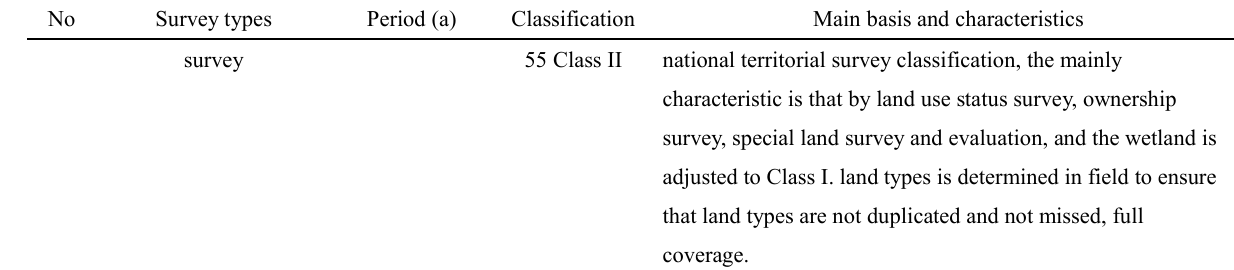
Table 1 Classification of national surveys in different